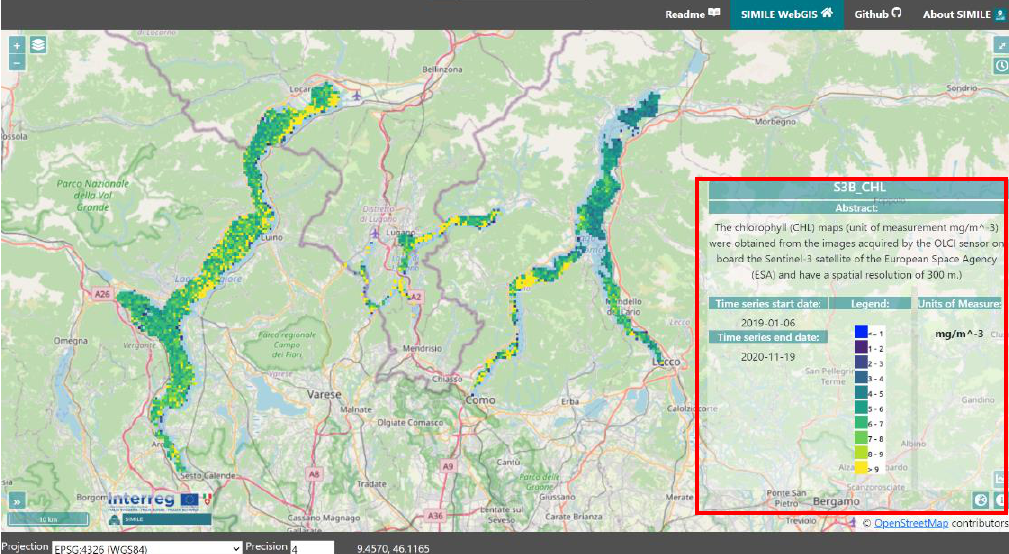
Figure 4. Metadata panel - Example Sentinel3B Chlorophyll-a